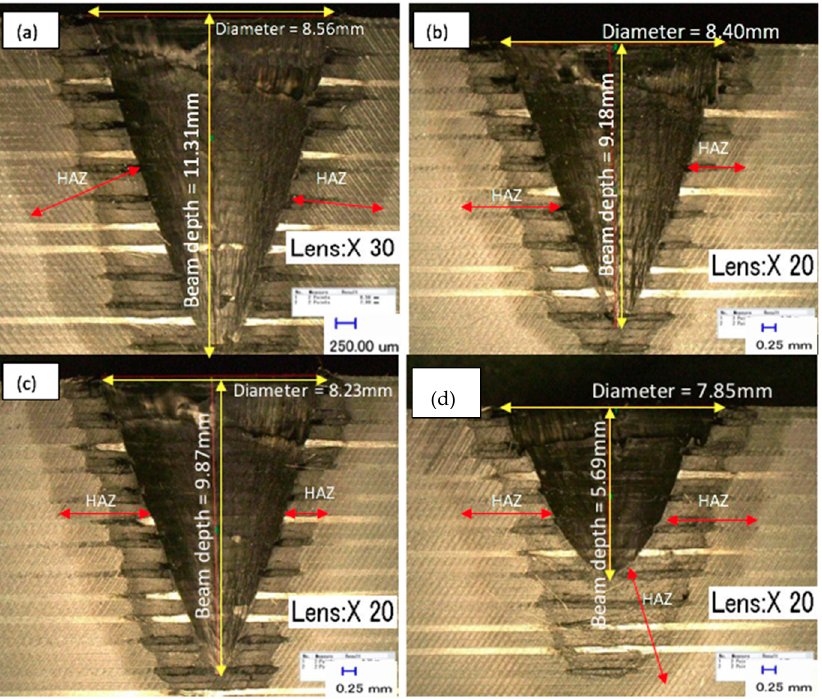
Figure 13. Influence of focal plane position (FPP) on hole depth and HAZ at four different view scales: ( a ) FPP: − 16; ( b ) FPP: − 14; ( c ) FPP: − 10; and ( d ) FPP: − 8.